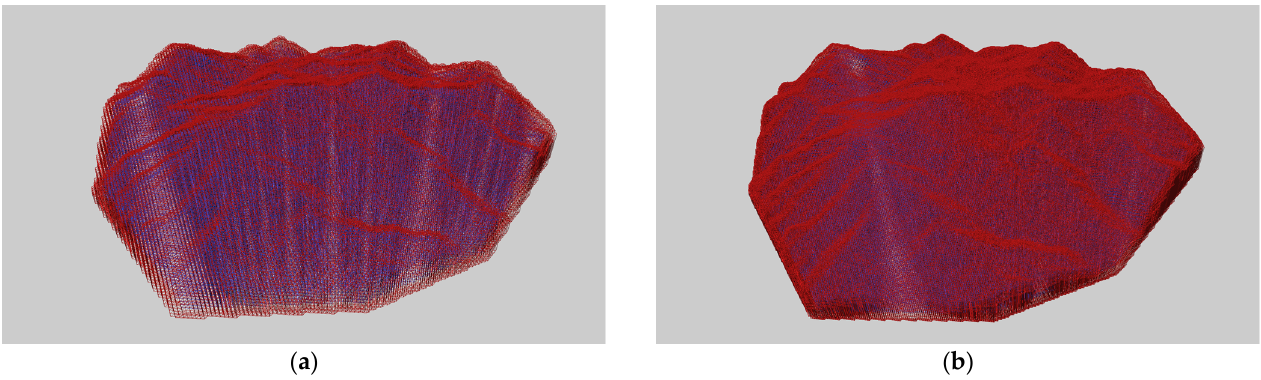
Figure 10. Wireframe models of the target area and its buffer with 80 m radius at the sphere grid levels of 18 ( a ) and 19 ( b ). Cells marked as the target area are shown in blue, and cells marked as the buffer are shown in red.